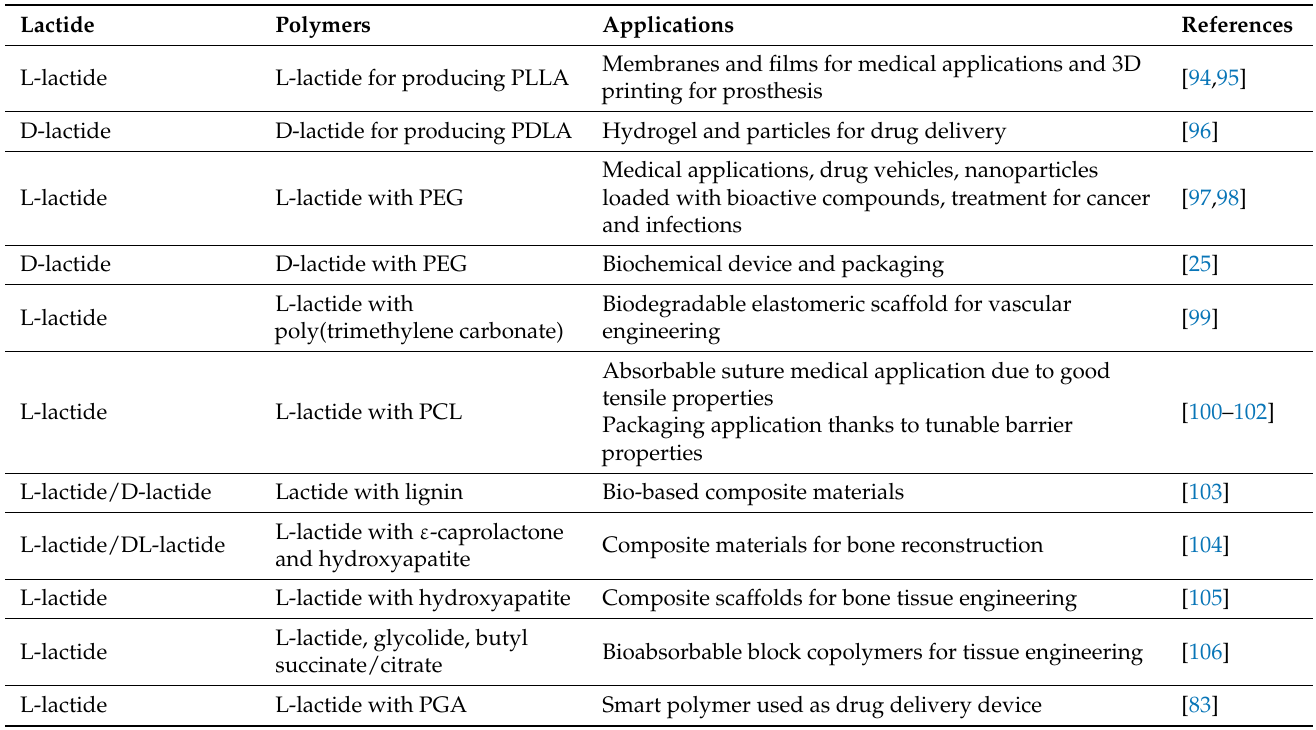
Table 4. Lactide as raw material for polymers production and their